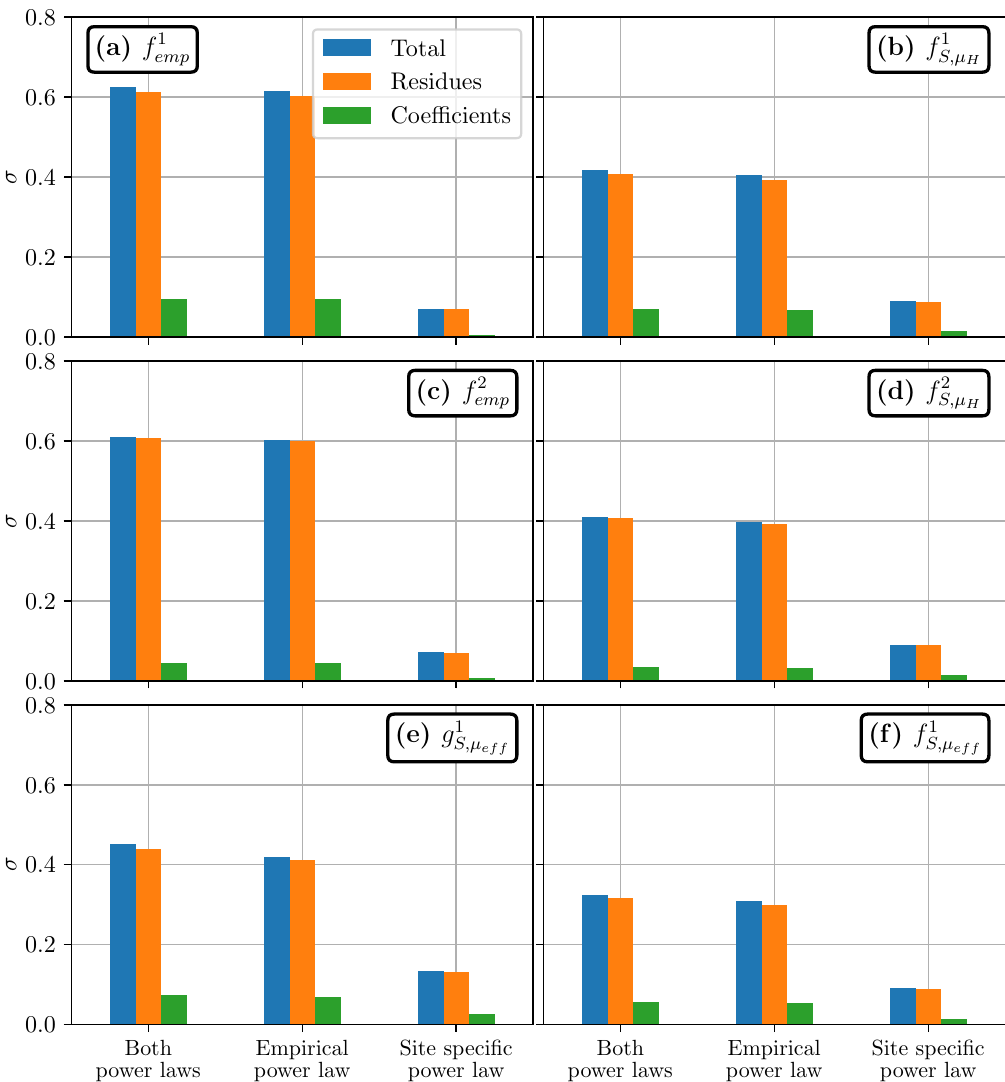
Figure 8. Uncertainty in travel distance estimation for the Samperre cliff case study, measured by the normalized standard deviation σ (see main body of the text). σ is computed by drawing randomly the power laws coefficients (green bars), the residuals (orange bars), or both (blue bars). As each estimation is the combination of two power laws, we consider uncertainties on the first power law derived from empirical databases (middle bars), on the second power law that is derived for the topography and simulation (right bars), or on both (left bars). ( a ) Estimation with f 1 emp . ( b ) Estimation with f 1 . ( c ) Estimation with f 2 emp . ( d ) Estimation with f 2 . ( e ) Estimation with g 1 . ( f ) Estimation S , µ H S , µ H S , µ eff with f 1 S , µ eff